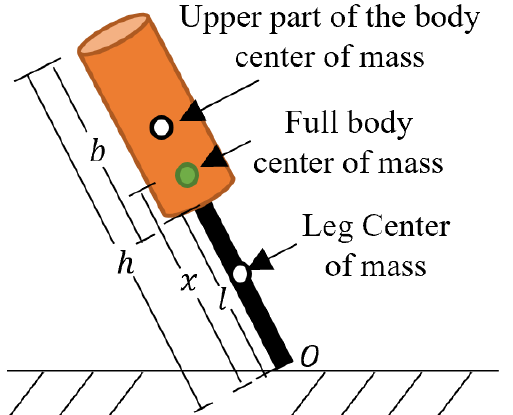
Figure 1. Human body represented as an inverted physical